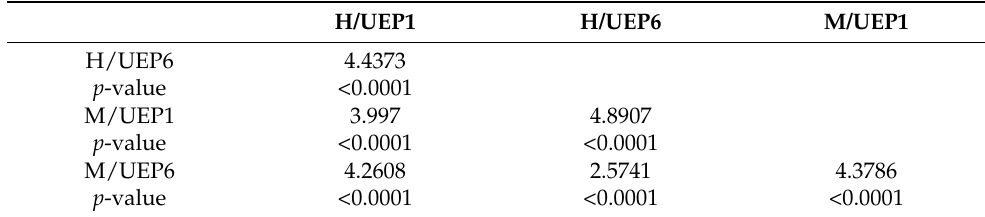
Table 2. Permutation test based on Mahalanobis distances between populations and sexes of Plagioscion magdalenae , with female Ciénaga de capote (H/UEP1) and Ciénaga de Jobo (H/UEP6), and male Ciénaga de capote (M/UEP1) and Ciénaga de Jobo (M/UEP6).